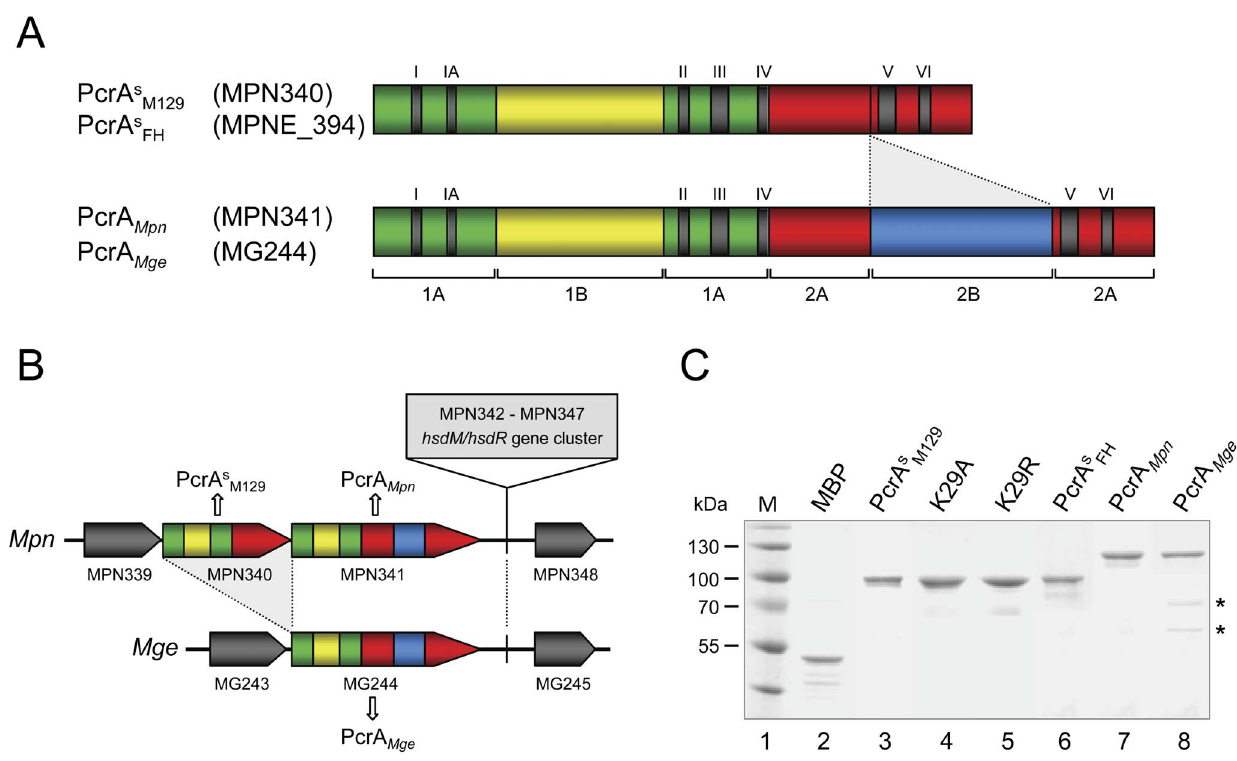
Figure 2. Predicted domain structure and purification of the PcrA-like proteins from M.pneumoniae and M.genitalium . (A) Schematic representation of the predicted (sub)domains (1A, 1B, 2A and 2B) and motifs (I, Ia and II to VI) of the PcrA-like proteins from M. pneumoniae and M. genitalium . The predictions are based on the multiple alignment shown in supporting Fig. S1, and on the crystal structures of PcrA/UvrD/Rep homologs [35,60]. Each subdomain is indicated by a separate color. Counterparts of the predicted 2B domains from PcrA Mpn and PcrA Mge (in blue) are absent from the PcrA s M129 and PcrA s FH proteins. (B) ORF structure of the genomes of M. pneumoniae ( Mpn , at the top) and M. genitalium ( Mge , at the bottom) in the region surrounding the ORFs encoding the PcrA-like proteins. All ORFs in these regions have the same orientation, i.e. 5 9 R 3 9 from left to right. The ORFs encoding the PcrA-like proteins are presented with the same color scheme as that of their encoded proteins in (A). Neighboring ORFs that are conserved between M. pneumoniae and M. genitalium are indicated in dark grey. The cluster of genes that is unique to M. pneumoniae (consisting of ORFs MPN342 to MPN347) is indicated at the top. (C) Purification of MBP, PcrA s M129 , K29A, K29R, PcrA s FH , PcrA Mpn and PcrA Mge . K29A and K29R are point mutants of protein PcrA s M129. All proteins were purified as fusions to MBP by using the same protocol. Some of the protein preparations, including those of MBP and PcrA Mge , contained minor protein species that are smaller than the full-length proteins. These species are not contaminants, but breakdown products of the full-length proteins; this was demonstrated by MALDI-TOF analysis of the two protein species that are indicated with asterisks (*). Samples of the purified proteins (as indicated above the lanes) were analyzed by SDS-PAGE (10%) and Coomassie brilliant blue (CBB)-staining. The sizes of protein markers (lane 1; PageRulerTM Prestained Protein Ladder [Fermentas]) are shown on the left-hand side of the figure in kDa.